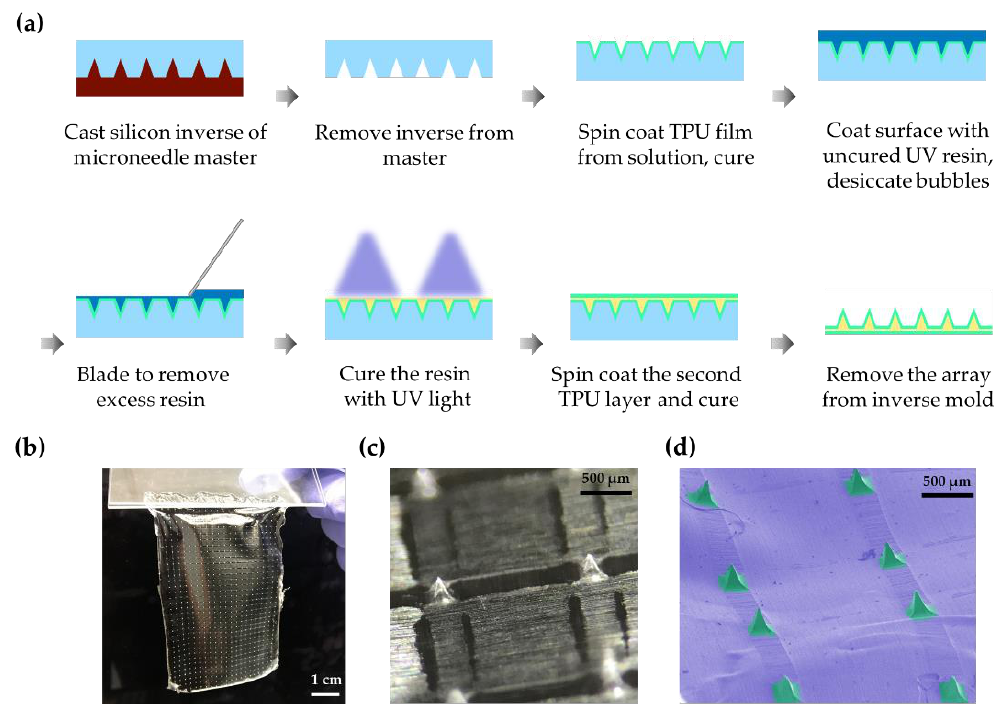
Figure 1. Fabrication of the microneedle array. ( a ) Schematic of the microneedle array fabrication; ( b ) Thin microneedle array peeled from the inverse mold; ( c ) Stereoscopic image of the magnified microneedle array; ( d ) Scanning electron microscopy of the microneedle array (pseudo-colored). TPU: thermoplastic polyurethane.